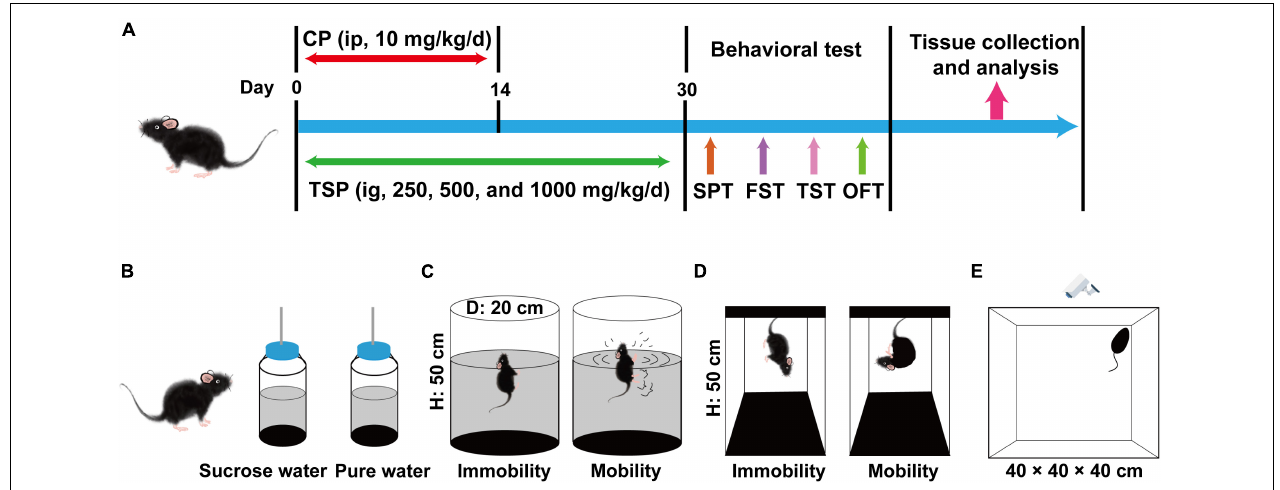
FIGURE 1 | Schematic diagram of the experimental procedures and behavioral experiments. (A) Schematic diagram of the experimental procedures. (B) Schematic diagram of the SPT experiment. (C) Schematic diagram of the FST experiment. (D) Schematic diagram of the TST experiment. (E) Schematic diagram of the OFT